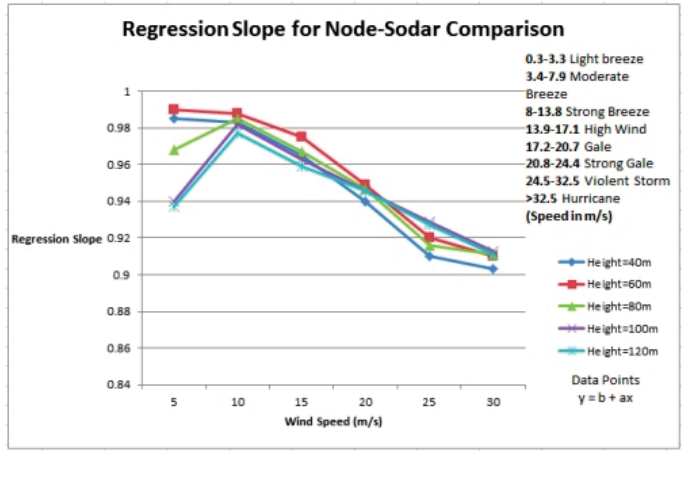
Figure 1. Comparison of site assessment technologies.